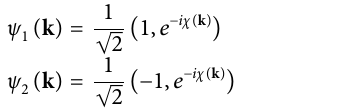
Frontiers in Chemistry |